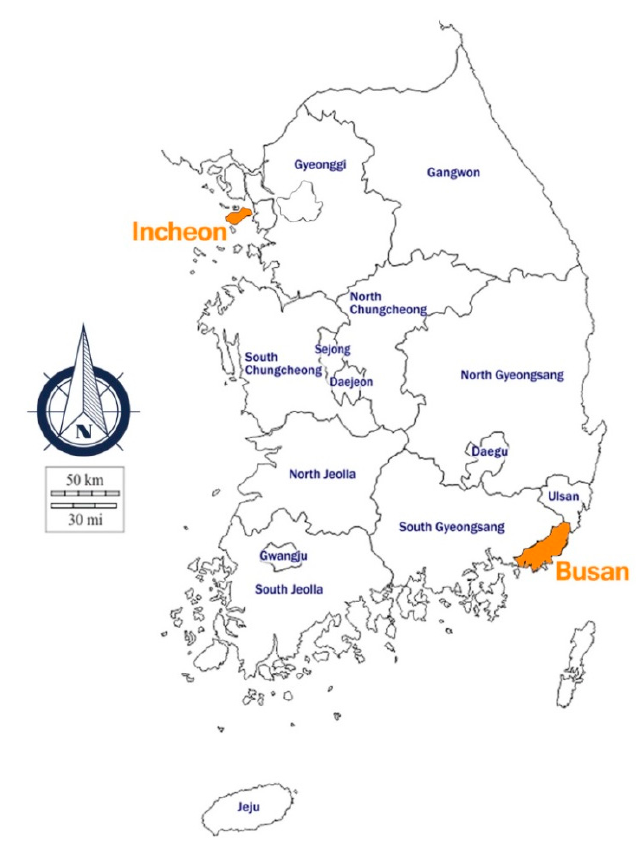
Figure 1. Map of study area.